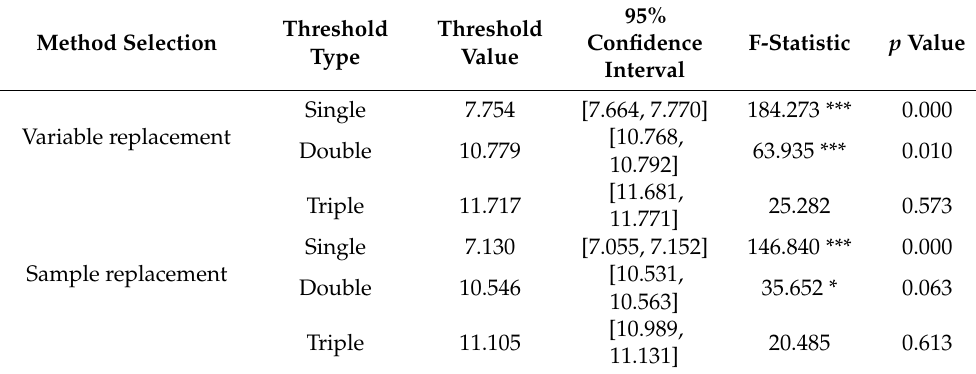
Table 7. Robustness test of threshold value estimation and threshold effect test.